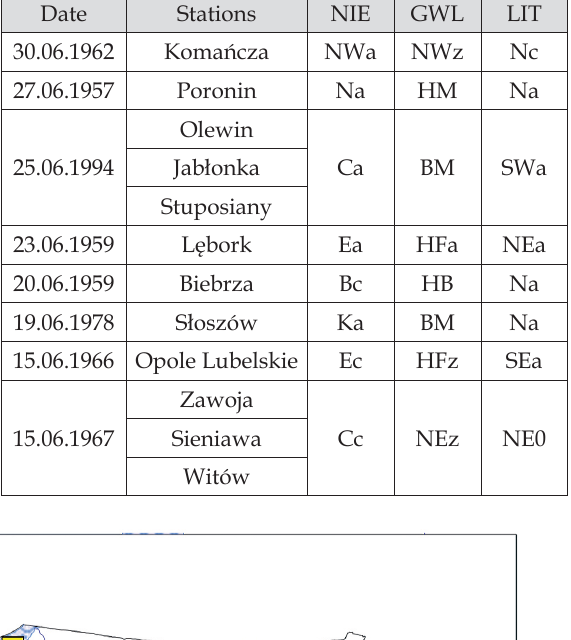
Table 1. The latest spring freezes recorded in Poland